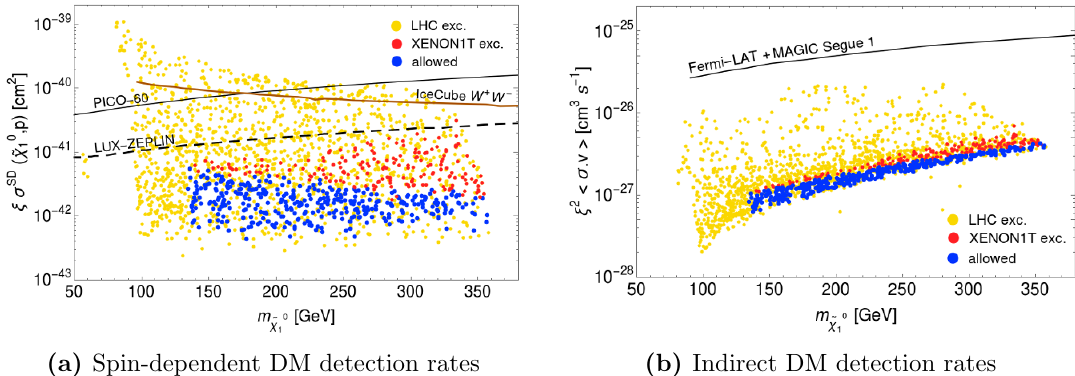
Figure 11. Locus of n = 1 landscape scan points for the NUHM3 model with (cid:22) = 100{360 GeV in the (a) (cid:24)(cid:27) SD ( (cid:31) 0 ; p ) vs. m and (b) (cid:24) 2 h (cid:27)v i vs. m e 1 e (cid:31) 0 1